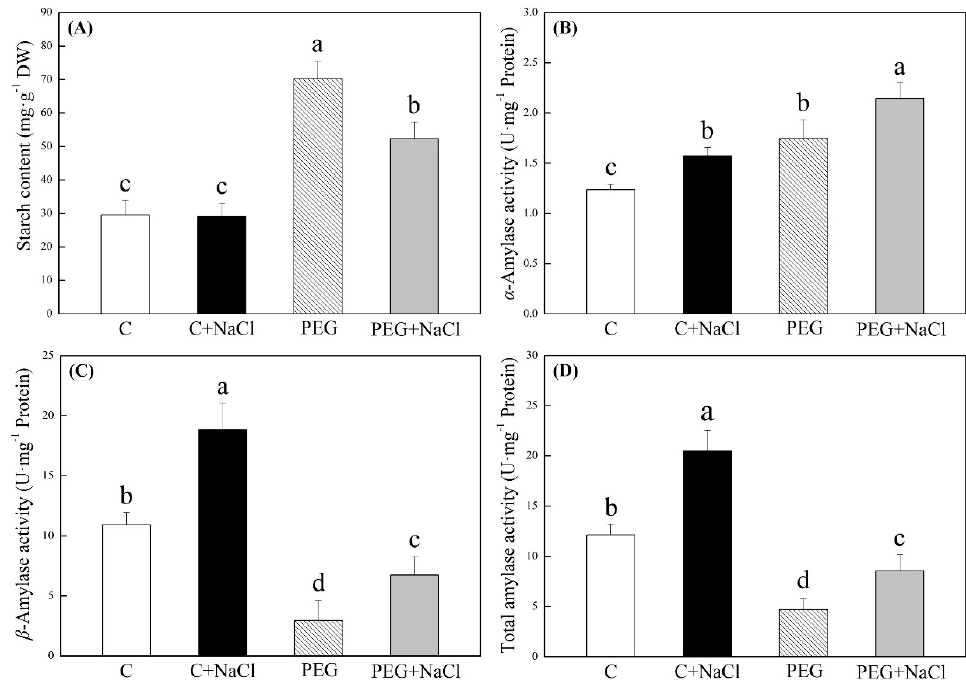
Figure 3. Effects of seeds soaking with water or NaCl (1 mM) on ( A ) starch content, ( B ) α -amylase activity, ( C ) β -amylase activity, and ( D ) total amylase activity after seven days of germination under normal conditions and under water stress induced by 19% polyethylene glycol (PEG) 6000. Vertical bars indicate ±SE of mean ( n = 6). Different letters above columns indicate significant differences ( p ≤ 0.05).